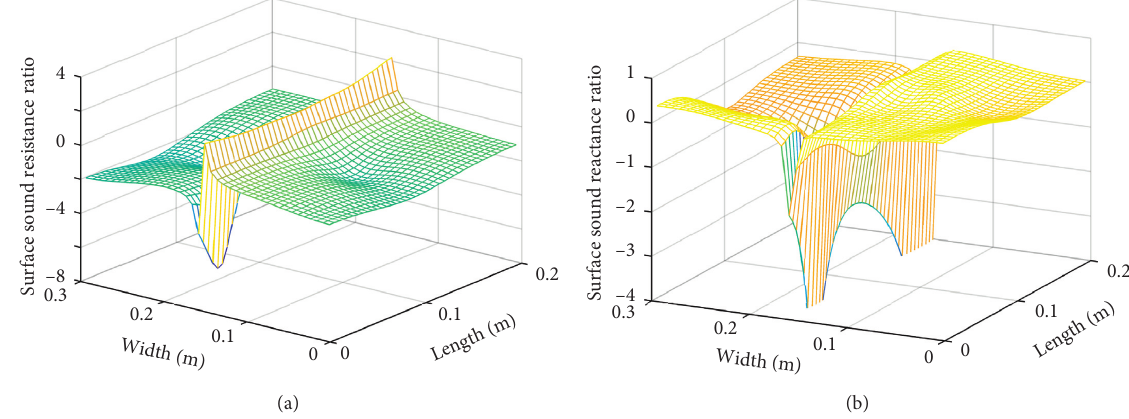
Figure 9: Surface sound impedance ratio of the active MPPA on the resonant frequency of the (3, 2) mode after control: (a) sound resistance ratio and (b) sound reactance ratio.